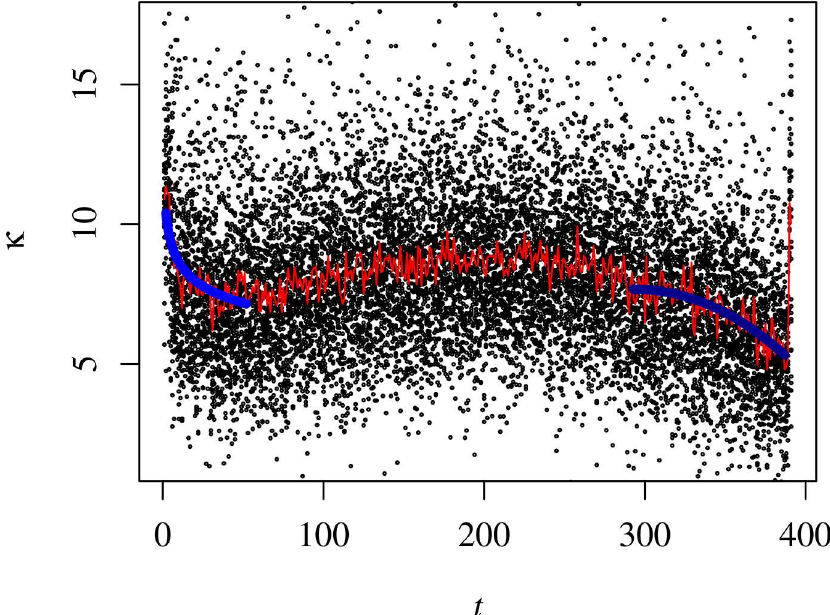
Fig 10. Intraday profile of the Kurtosis during 1S04. The black dots represent the values of κ i ( t ; 1 S 04) and the red line ~ k ð t ;1 S 04 Þ . The ultramarineand navy blue lines represent the adjustments given by the first and second formulae in Eq (18), respectively. In this specific case the parameters are β m = 0.11 ± 0.02 and β a = 2.16 ±